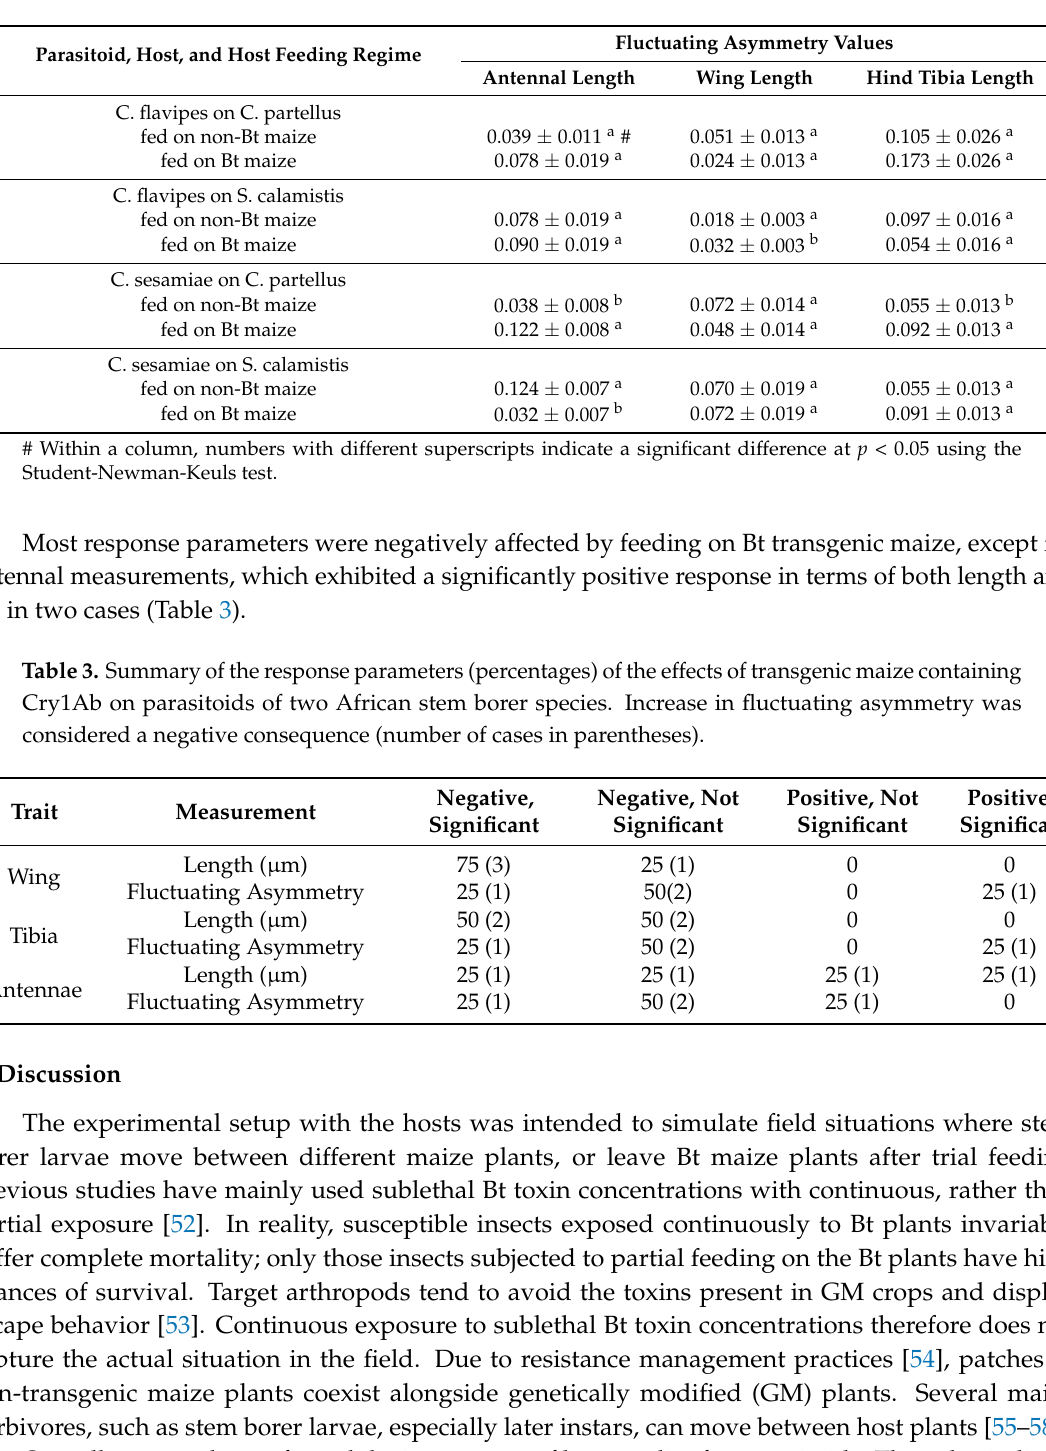
Table 2. Fluctuating asymmetry (Mean ± SE) in antennal length, wing length, and hind tibia length of the parasitoids Cotesia flavipes and Cotesia sesamiae developed on stem borer hosts Chilo partellus and Sesamia calamistis subjected to transient feeding on Bt maize ( n = 20 in each combination).